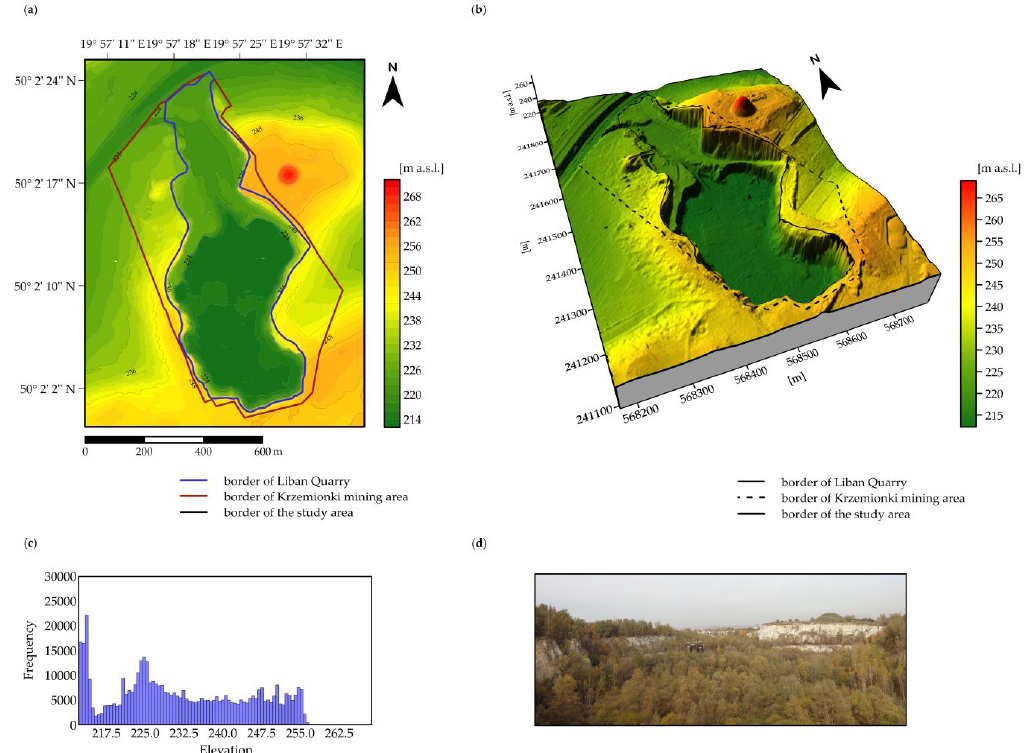
Figure 3. The present relief of the Krzemionki mining area and its surroundings: ( a ) hypsometric map; ( b ) digital elevation model (DEM); ( c ) histogram of raster image calculated on the basis of the hypsometric map; ( d ) S-W wall of Liban Quarry (left) and Krakus Mound (right) (October 2019). ( a ), ( b ), ( c ) from the airborne laser scanning (LiDAR). Coordinate system: WGS84 ( a ) and ETRS89/Poland CS92 ( b ).